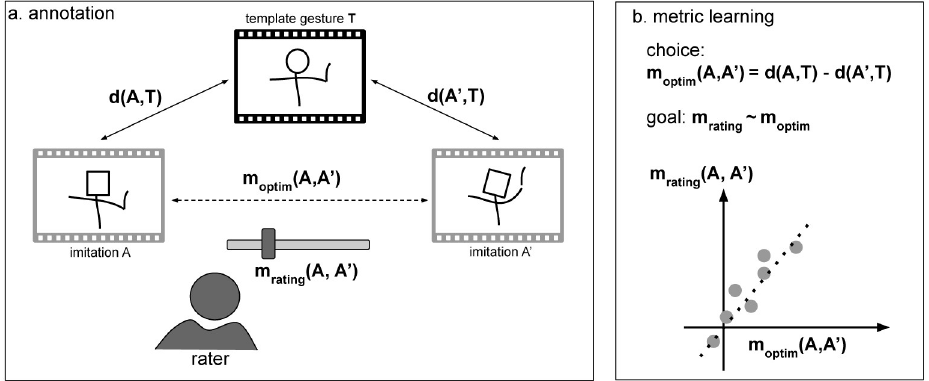
Fig 1. Overall setup for the paper. (a) Performance pairs ( A , A 0 ) are sampled for comparison against a reference T by judges on videos and computing algorithms on sensor data. (b) Metric learning acts on parameters of the compute function m through search or optimisation to produce a meaningful relationship with m optim function d